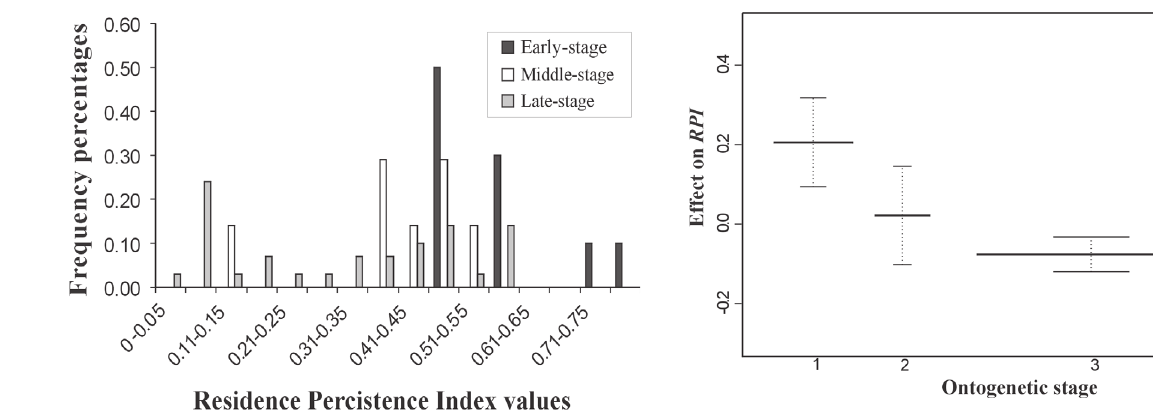
Fig . 4. – General linear-model-derived ontogenetic stage effect on Fig . 3. – Shoal frequency percentages of RPI values for the three resident persistence index (rpi ). the fitted values are adjusted to specified ontogenetic stages average zero and the broken lines indicate two standard errors. Bar widths correspond to the observation frequency at each ontogenetic stage